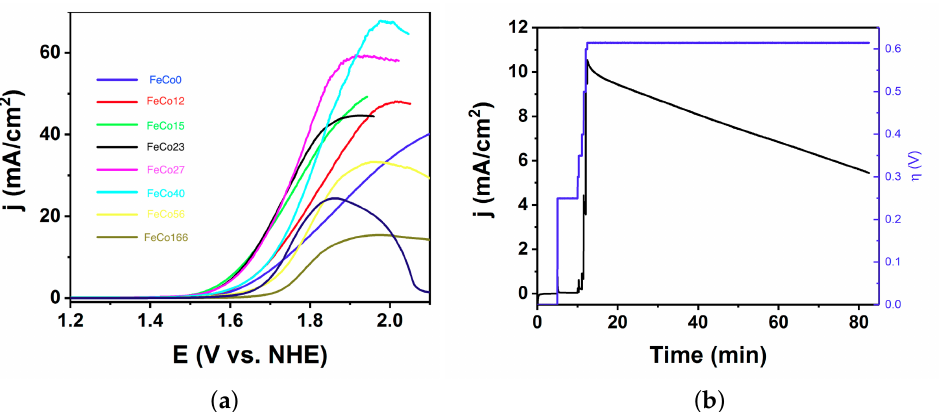
Figure 5. ( a ) Linear sweep voltammetry (1 mV/s) with FeCo Z electrodes. ( b ) Chronoamperometry with a FeCo23 electrode. Electrolyte: H 3 PO 4 pH = 1.5 solution with KNO 3 (1 M)